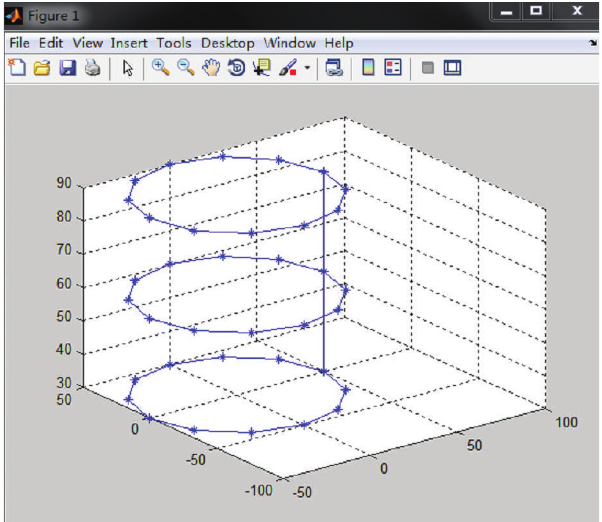
Table 2: Measuring points on section 2 (/mm).